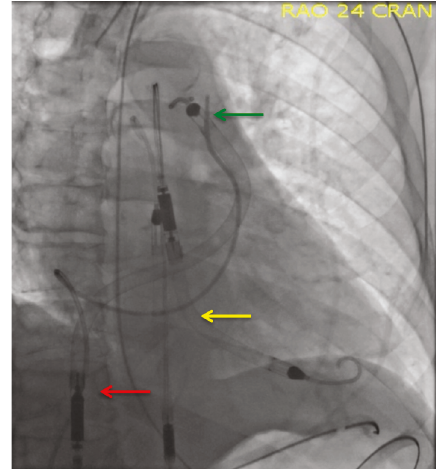
Figure 3: Chest X-ray showing RP Impella with the inlet situated in the inferior vena cava (red arrow) and the outlet in the pulmonary artery (green arrow) and Impella 5.0 with the inlet in the left ventricle and the outlet in the ascending aorta (yellow